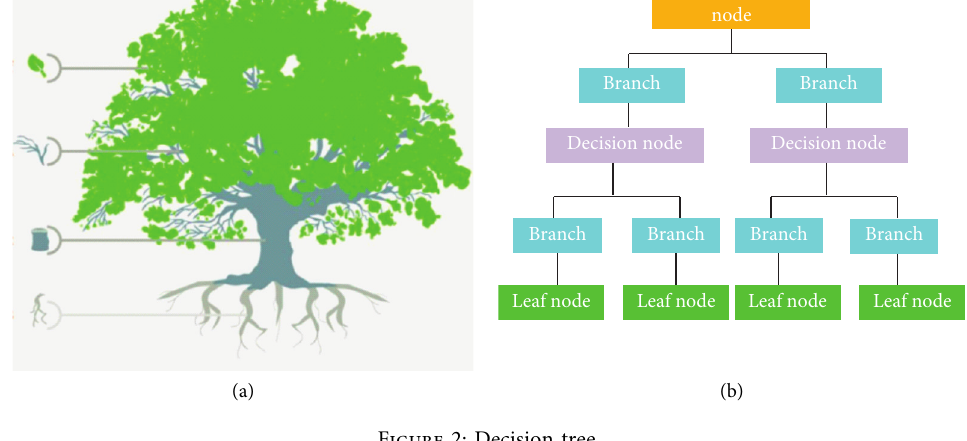
Figure 2: Decision